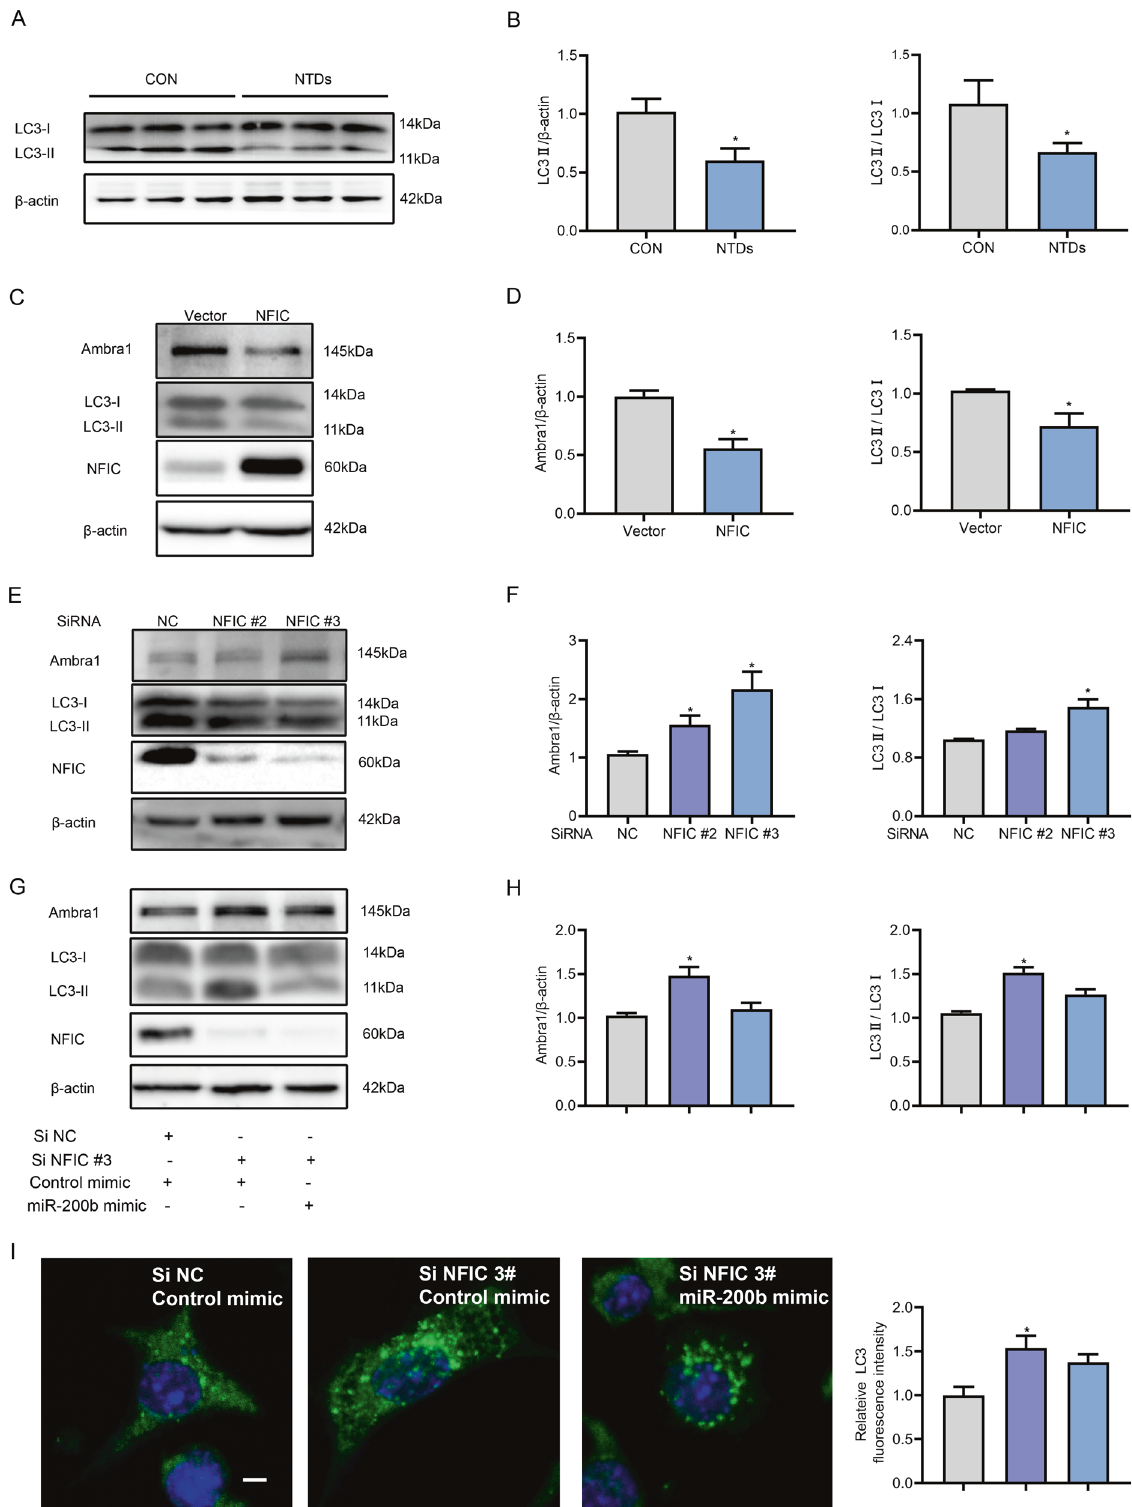
Fig. 4 miR-200b rescues NFIC knockdown-induced autophagy. A , B Protein expression of LC3 in normal and ATRA-induced NTD embryos ( n = 3). C , D Protein levels of Ambra1, LC3, and NFIC after C17.2 cells were transfected with the NFIC plasmid or the control vector. E , F Effect of NFIC SiRNA on the protein expression of Ambra1, LC3, and NFIC. G , H Ambra1, LC3, and NFIC protein expression in cells transfected with the NFIC SiRNA and the control mimic or the miR-200b mimic. I The fl uorescence intensity of LC3 in cells transfected with the NFIC SiRNA and the control mimic or the miR-200b mimic, scale bar = 5 µm. Experiments were repeated three times. * P < 0.05 vs. control group.